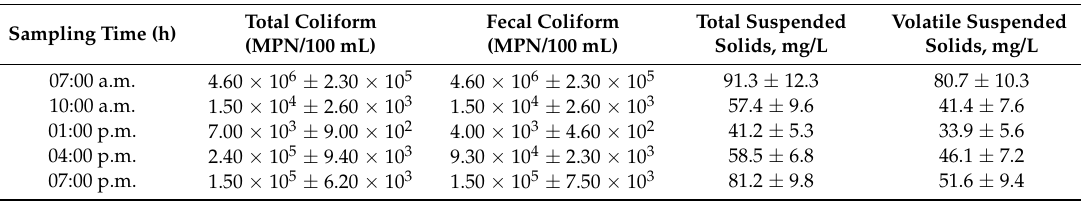
Table 2. Total and fecal coliforms and suspended matter characterization of secondary effluents of municipal wastewater treatment plants.